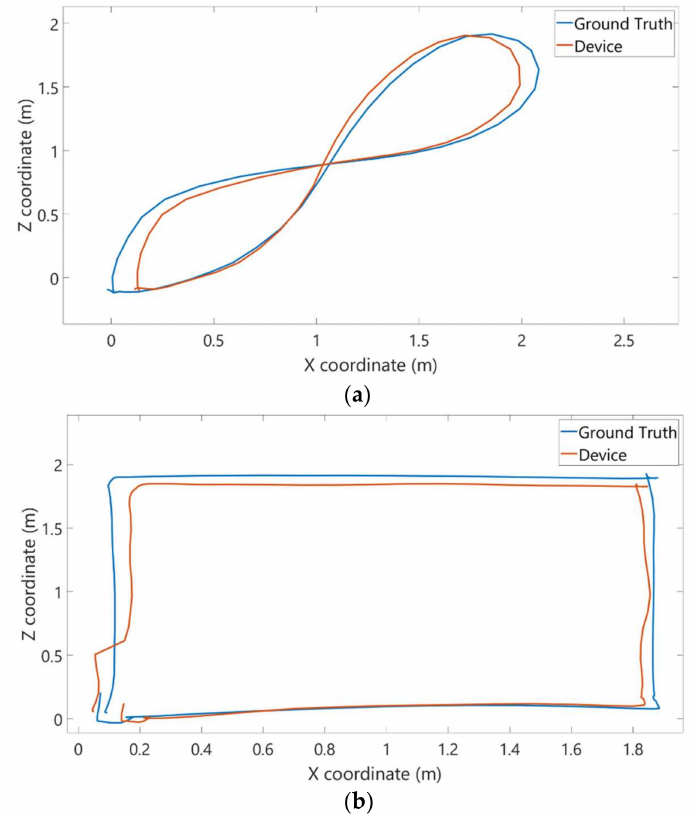
Figure 7. Examples of eight-shaped ( a ) and square-shaped ( b ) paths tracked by the motion capture system (blue line) and the corresponding aligned paths tracked by the selected device (red line).